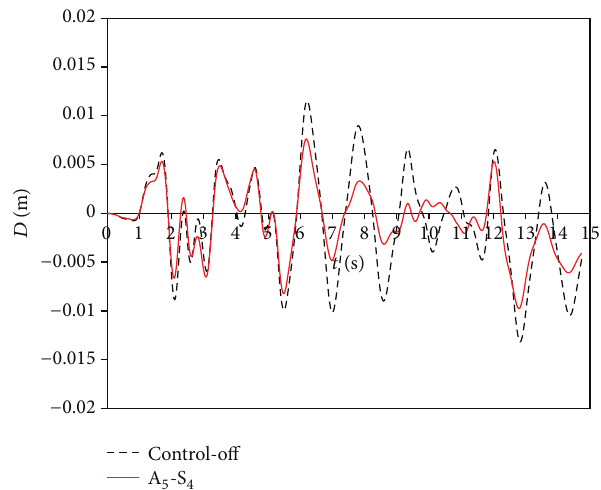
Figure 8: The time history displacement for the highest floor of the seven-story shear building excited by the Elcentro